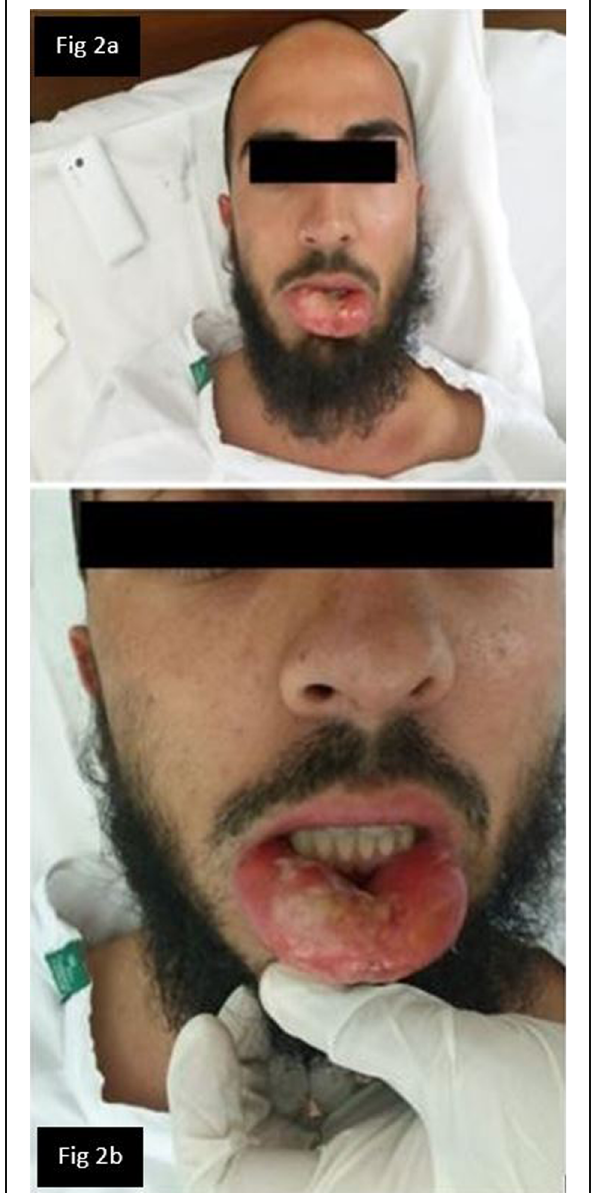
Fig. 2 a , b Isolated lower lip swelling